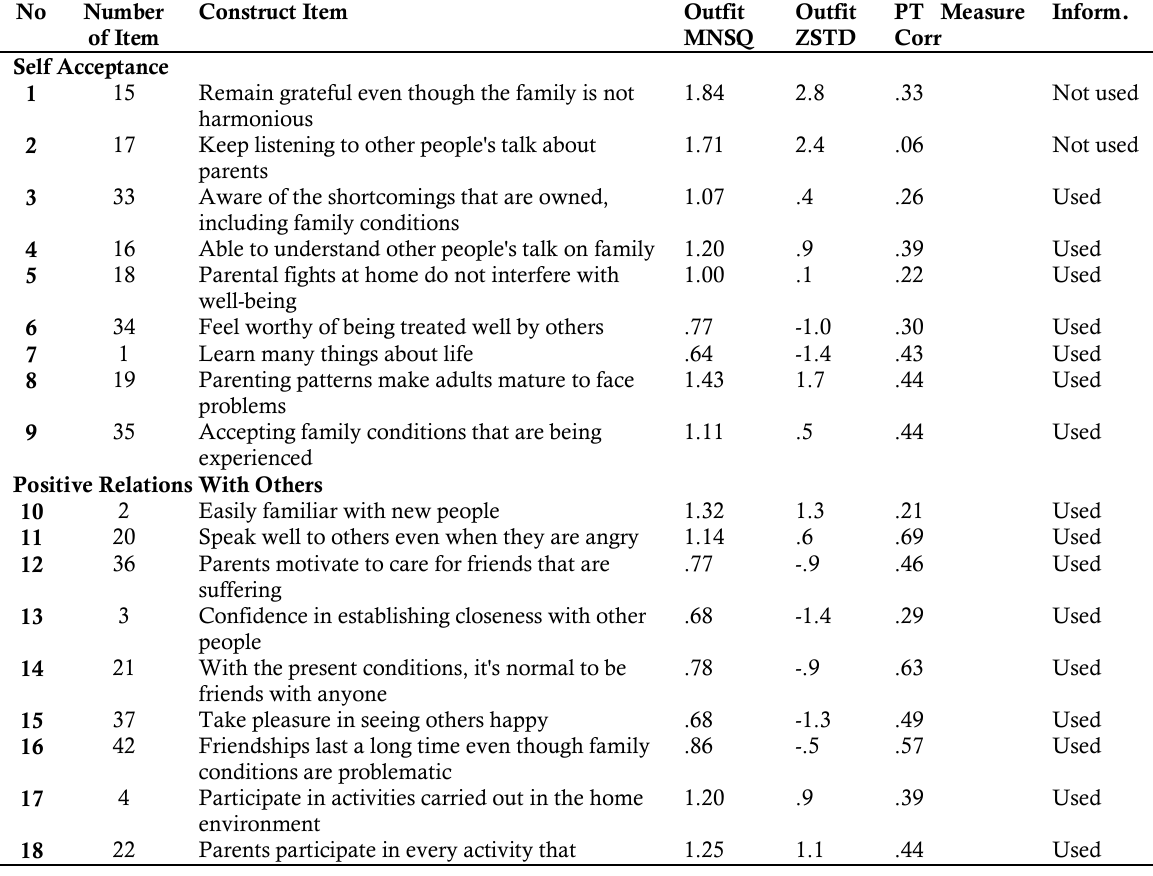
Table 2. Item Statistic (Outfit MNSQ. Outfit ZSTD, Pt Measure